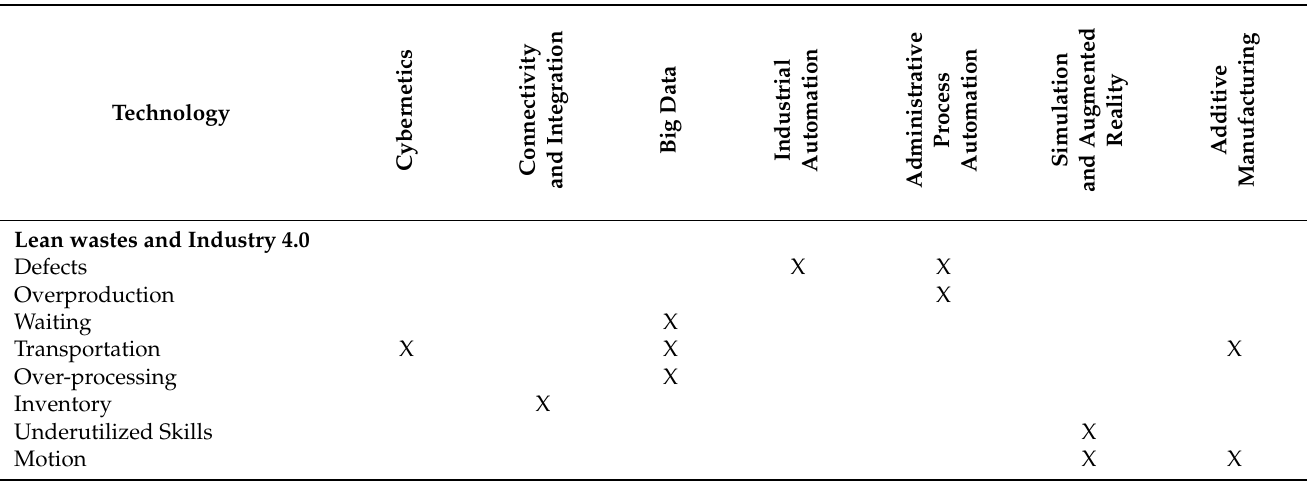
Table 3. Analysis of the article “Using Industry 4.0 Capabilities for Identifying and Eliminating Lean Wastes” [55].